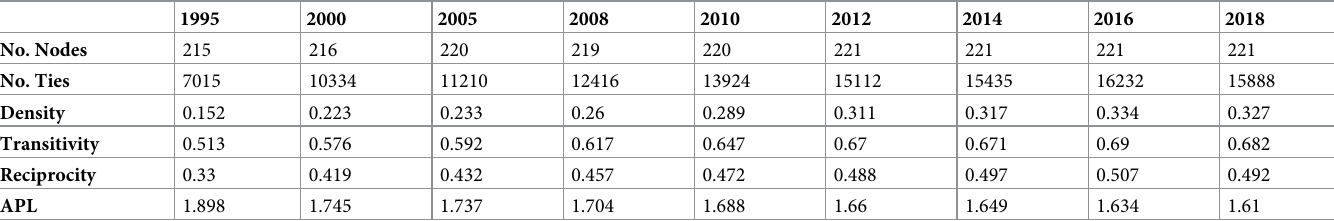
Table 1. The structural features of the global tourist flow network over